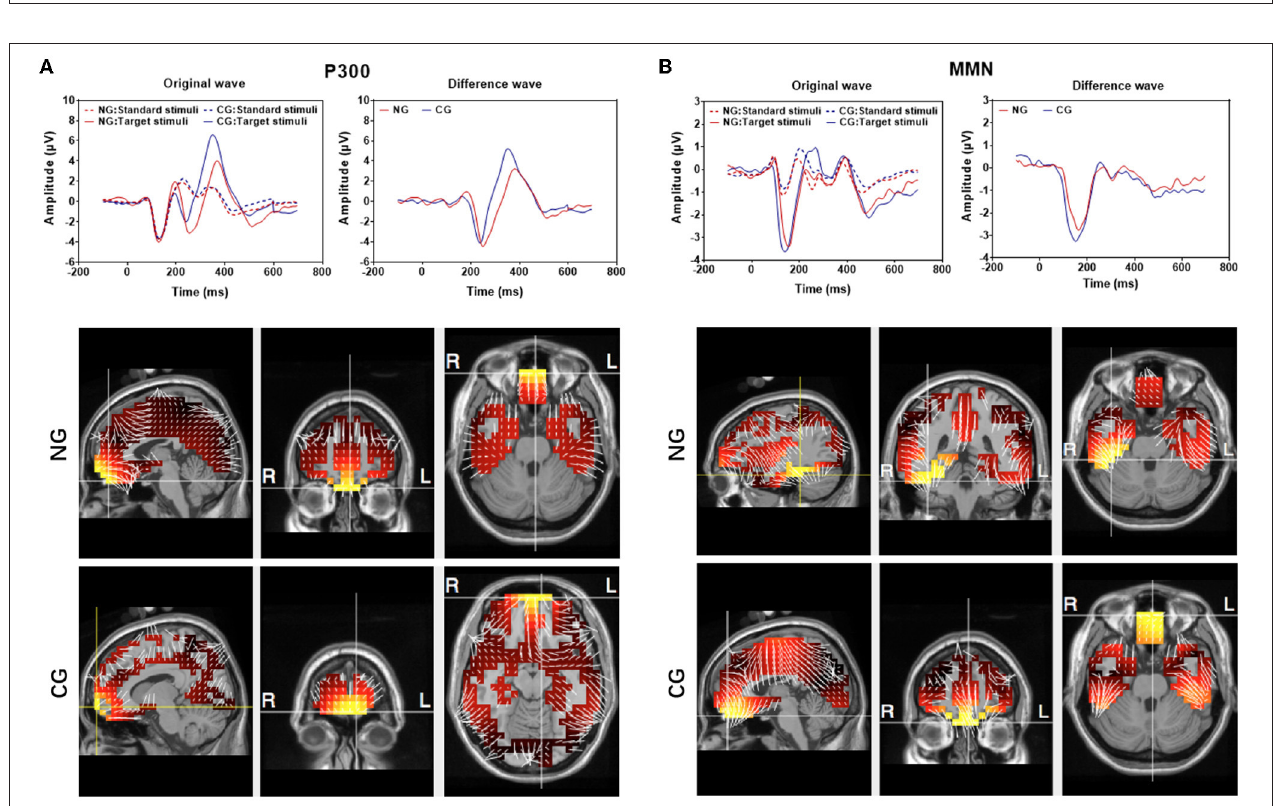
FIGURE 3 | L-CNE group compared with the H-CNE group. For subjects aged over 40 years old, attention, visuospatial and executive, and education adjustment scores showed a difference between H-CNE and L-CNE. (B) The scatter plot depicted the decrease of MoCA-BJ scores with the increase of CNE among participants aged over 40 years or younger. For educational adjusted scores, attention, visuospatial/executive, naming, and language scores, there were significant differences in the rate of decrease in scores with CNE. The asterisks indicates statistical significance between the L-CNE and the H-CNE group in the same age group (*, < 0.05; **, < 0.01; ***, p < 0.001).